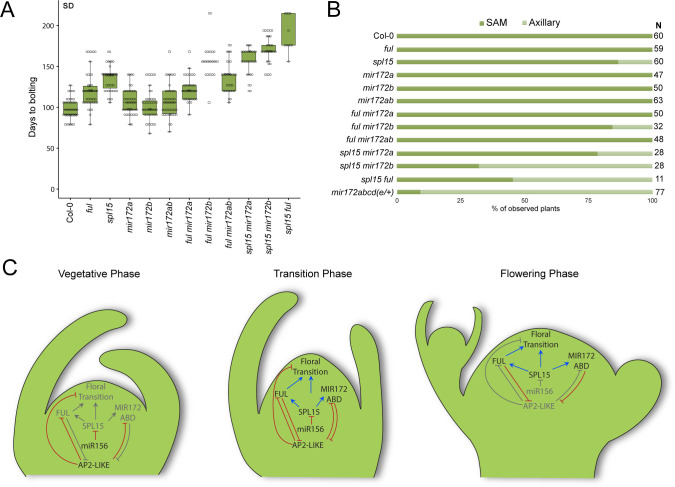
Genetic interactions between mir172, ful, and spl15 mutations.(A) A box plot depicting DTB for plants carrying the indicated combinations of spl15-1, ful-2, and mir172 mutations and grown in SD conditions. Data underlying panel A are provided in S2 Data. (B) A bar chart depicting the proportion of plants from (A) that flowered from the SAM or axillary meristems. The data for combinations between ful-2, mir172a-2, and mir172b-3 are supplemented by data from S12B Fig. Data for mir172abcd(e/+) are taken from Fig 3B and are shown here for comparison. The total number, N, of plants analyzed is indicated. Data underlying panel B are provided in S2 Data. (C) Schematic to summarize the interactions coordinated by SPL15 during the floral transition. Red lines with flat caps indicate negative regulation, and blue arrows indicate positive regulation. Gray text and line color indicate inactivity at that stage of development. Black text indicates activity at that stage of development. AP2-LIKE, APETALA2-LIKE; DTB, days to bolting; FUL, FRUITFULL; SAM, shoot apical meristem; SD, short-day; SPL, SQUAMOSA PROMOTER BINDING PROTEIN-LIKE.